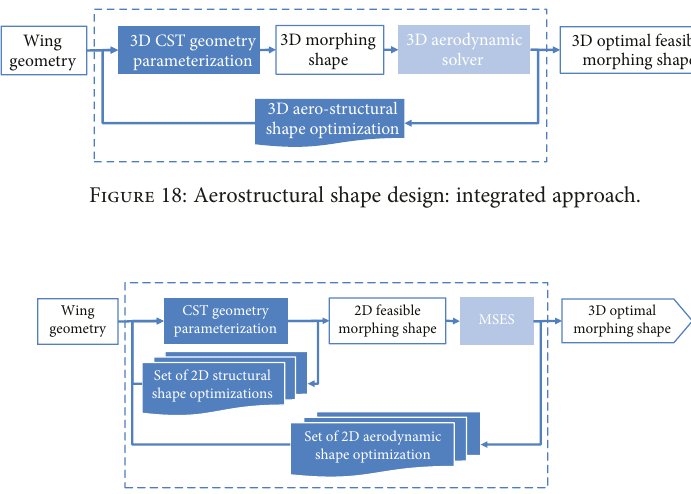
Figure 19: Aerostructural shape design: hybrid approach for high-lift con fi